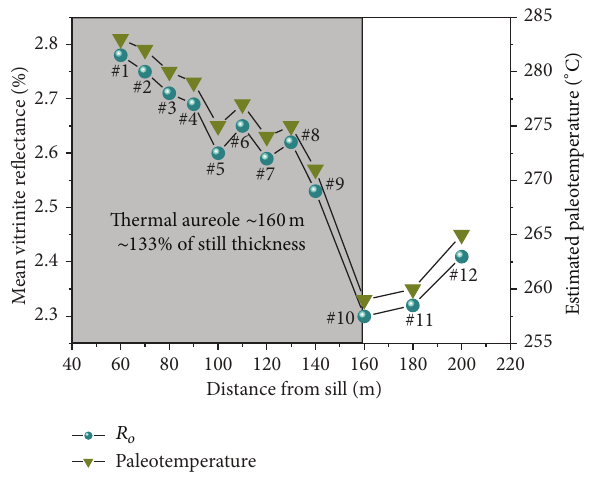
Figure 3: Variation in vitrinite reflectance and estimated paleotem- peratures with distance from the